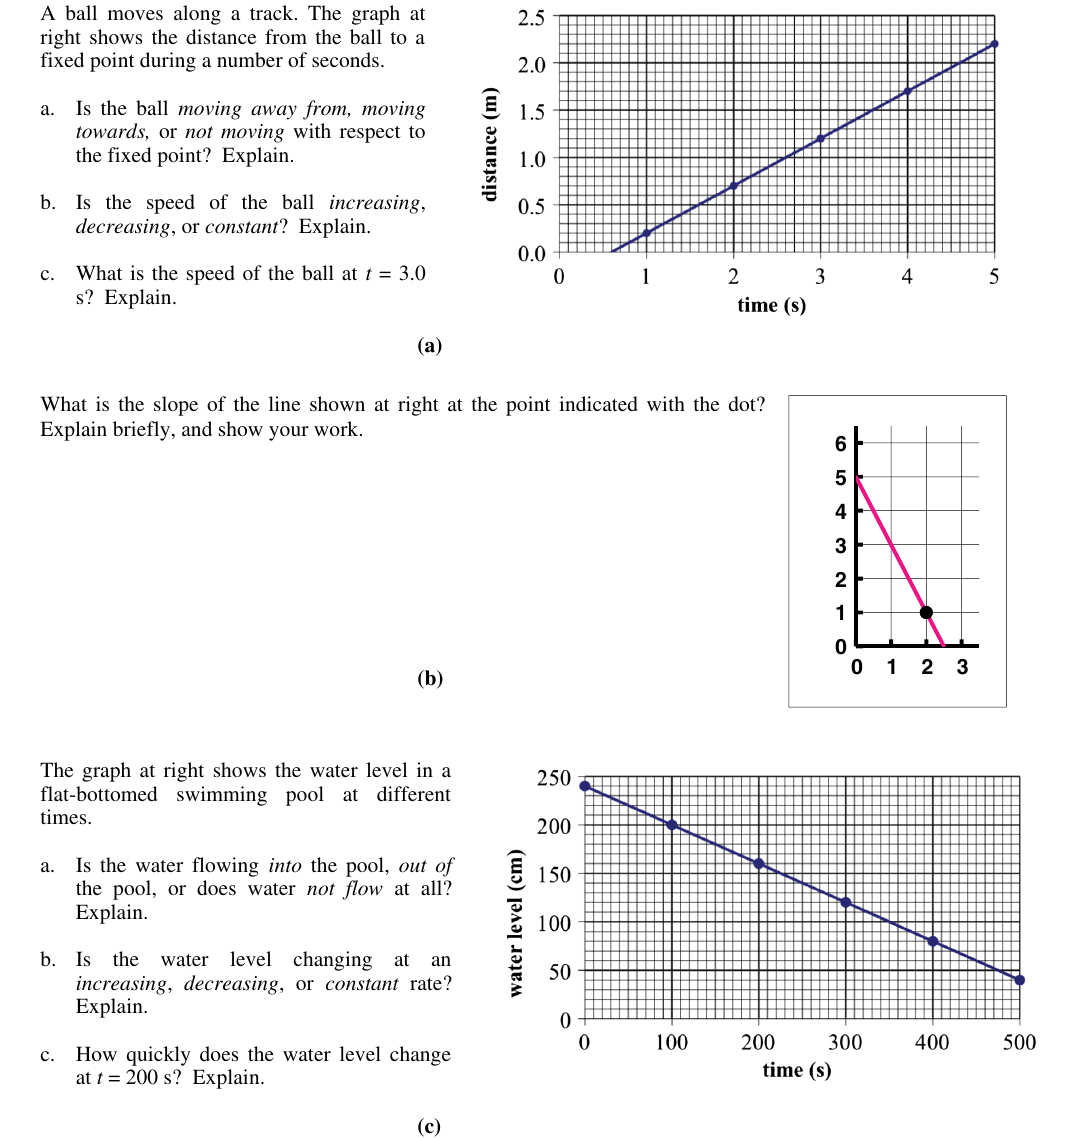
FIG. 1 (color online). Typical graphs used to investigate difficulties with determining slope from a linear graph: (a) distance-time graph; (b) y; x graph; (c) water level versus time graph. On some occasions, the best-fit line was omitted from graphs like (a) and (c). This made no significant difference to the answers